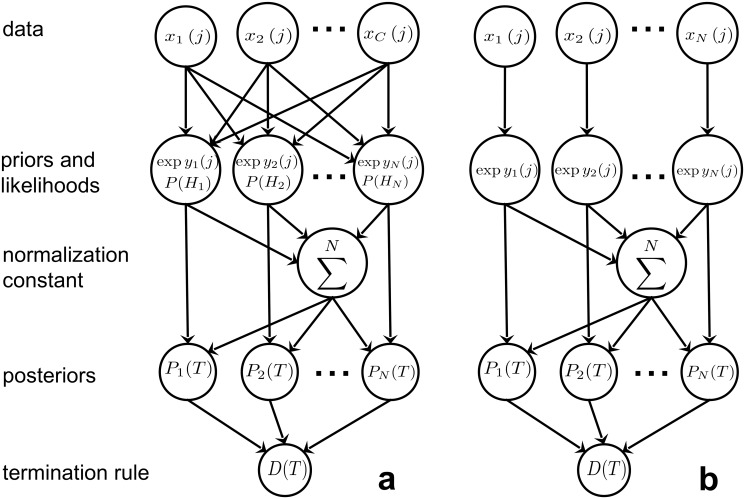
MSPRT in schematic form.Panel a shows the general MSPRT where all the C data streams contribute to all of the N likelihoods and thus posteriors, which are then evaluated at a termination stage. Panel b only shows the effective components after all simplifications have been applied.